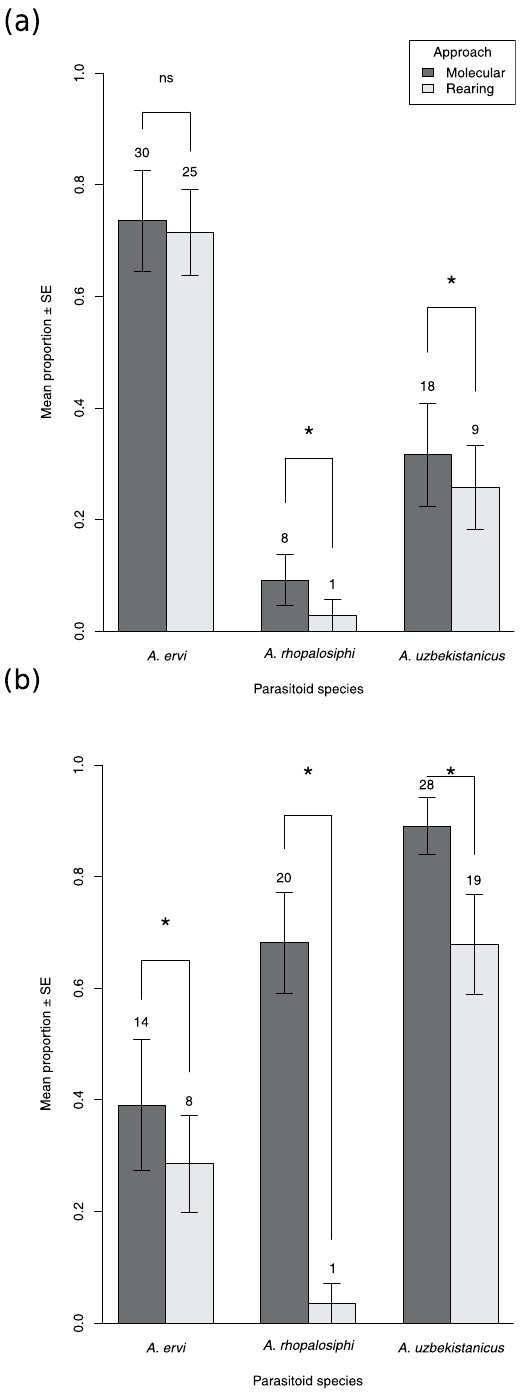
Figure 5. Mean relative proportions of each detected parasitoid species inside parasitized aphids (by molecular approach) and the mean number of adult emergences (by rearing approach) of the three most abundant parasitoid species ( ± standard error (SE)) in the case of: ( a ) high aphid abundance (date one); and ( b ) low aphid abundance (date four). For the molecular approach, the numbers on each column represent the minimal number of ovipositions for each parasitoid species (there could be more than one parasitoid species in one aphid). For the rearing approach, the numbers on each column represent the number of emerged individuals of each species (morphological identification). * denotes statistical differences and ns denotes non-statistical differences based on the t- test on proportion analyses at p <